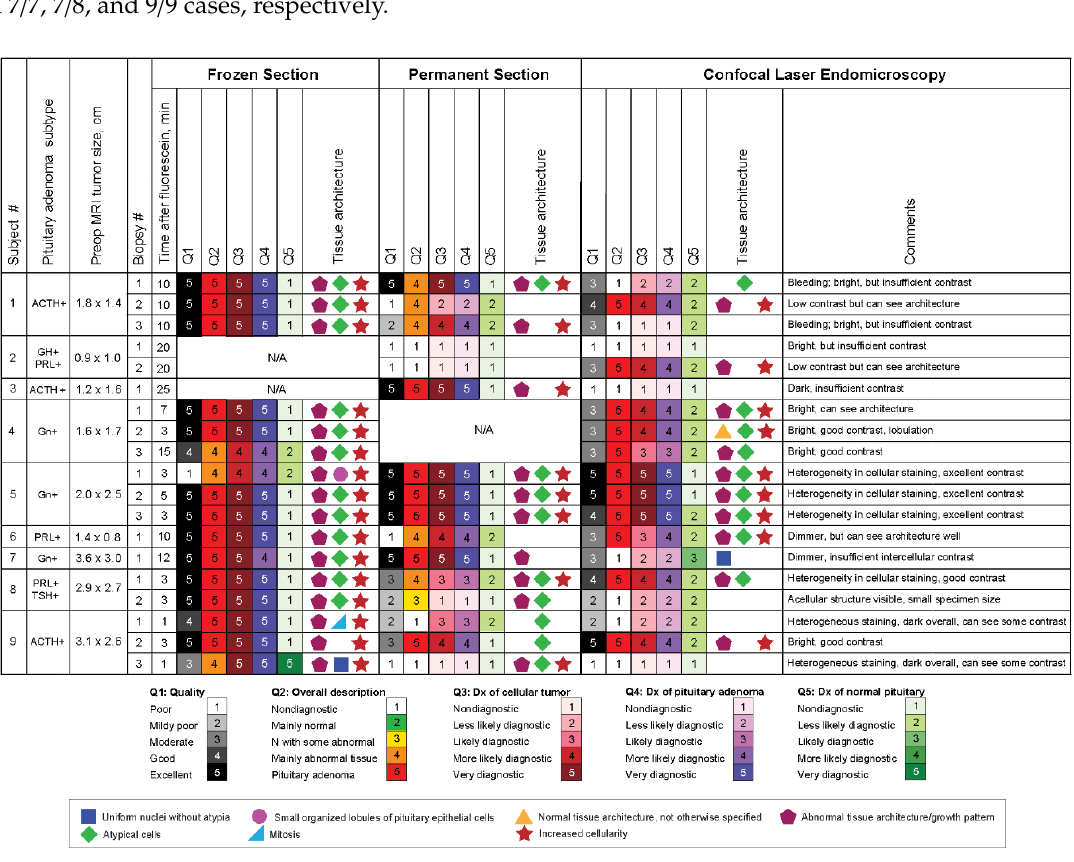
Figure 3. Results of a qualitative comparative assessment of frozen sections, fixed permanent sections, and confocal laser endomicroscopy images of pituitary adenomas by a neuropathologist blinded to patient data. Abbreviations: ACTH, adrenocorticotropic hormone; Dx, diagnosis; GH, growth hormone; Gn, gonadotroph; N, normal; N/A, not applicable; PRL, prolactin; TSH, thyroid stimulating hormone. Used with permission from Barrow Neurological Institute, Phoenix, Arizona.